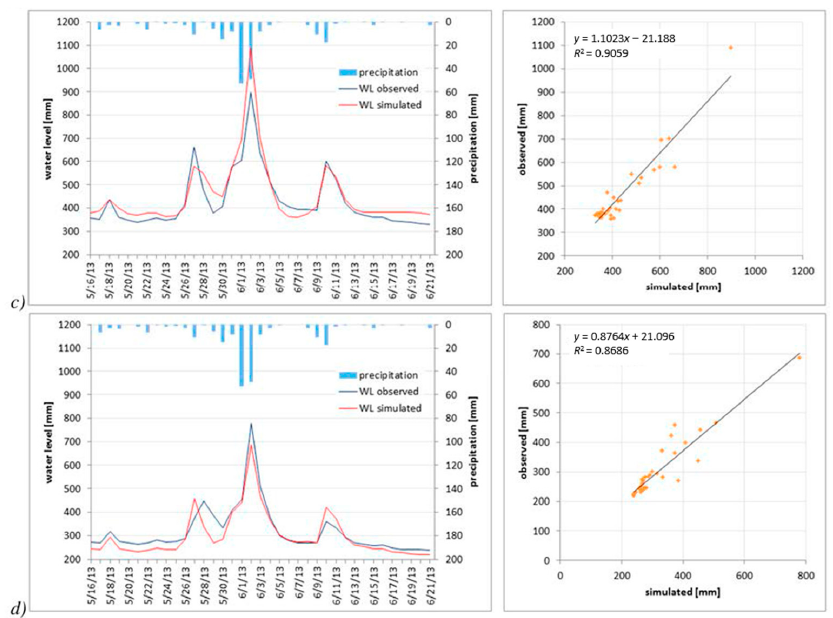
Figure 7. Simulation scenario SC1—Regional flood from recurrent heavy precipitation, 16 May–21 July 2013 at stations: ( a ) RKM; ( b ) JAV; ( c ) ROK; and ( d ) HAJ.